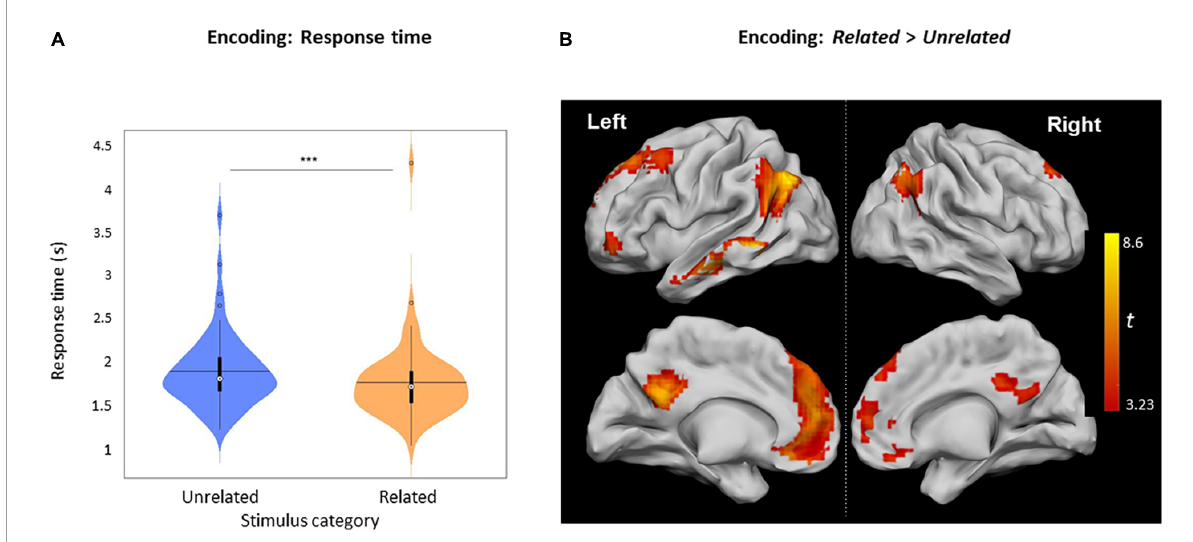
FIGURE3 Related vs. Unrelated during encoding . (A) Violin plots of RTs for Related and Unrelated judgments during encoding (***: p < 0.001), horizontal lines represent the mean, thick vertical black bars are a box plot, the center white circle represents the median. (B) Clusters with increased activity during Related versus Unrelated judgments ( p < 0.05), FWE-cluster corrected, cluster-forming threshold = 80 voxels [at p < 0.001